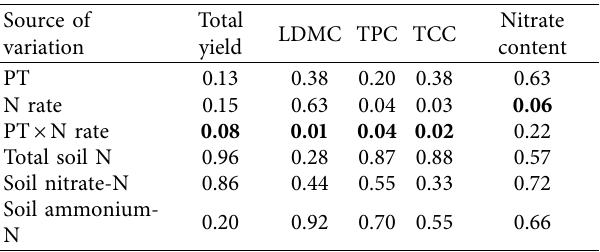
Figure 3: Interaction effects of (a) planting time and days after sowing (DAS) and (b) nitrogen (N) rate and DAS on leaf chlorophyll content. Means sharing the same letter are not significantly different at p < 0 . 05. Table 4: Analysis of variance p values for the main and interaction effects of planting time (PT), nitrogen (N) rate and total soil N, nitrate-N, and ammonium-N covariates on the number of branches, total yield, and leaf dry matter content (LDMC), total phenolic content (TPC), and total carotenoid content